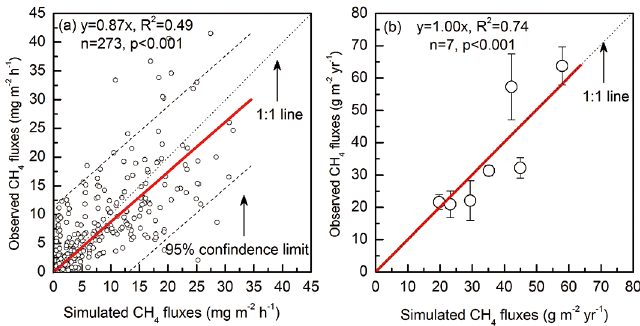
Fig 4. Observed vs. simulated CH 4 emissions from M-D site (June 2002 – December 2004) and M-C site (June 2002 – December 2005) on the Sanjiang Plain. (a) CH 4 fluxes, dashed lines are 95% confidence limits. (b) Total amount of annual/seasonal CH 4 emissions, dotted line is 1:1 line, the vertical bars are standard deviations from 3 sampling replicates.